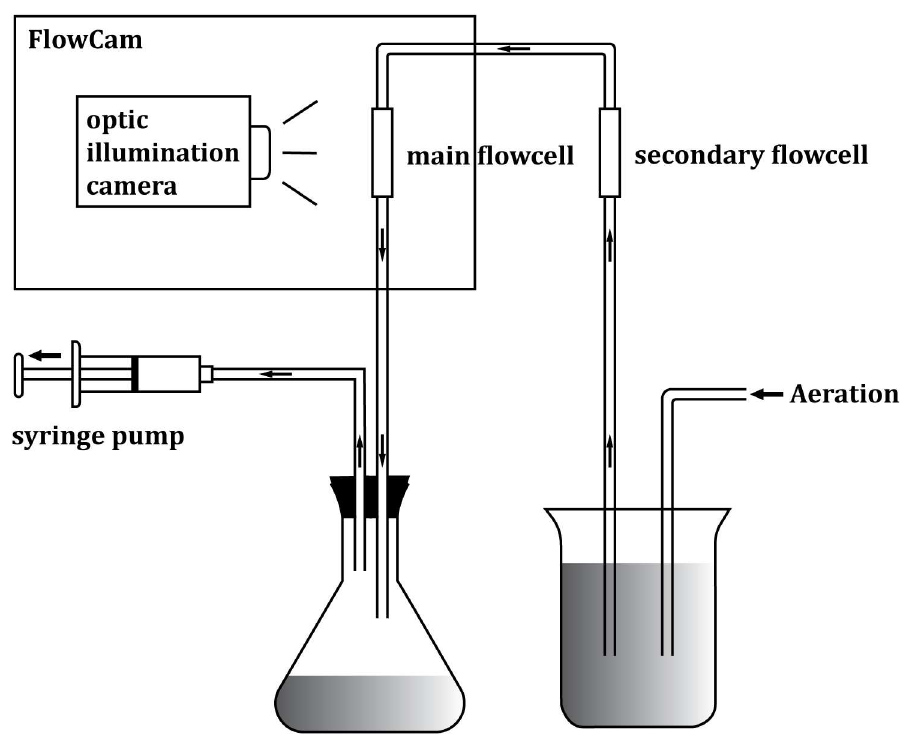
Fig 1. Schematic illustration of the modified FlowCAM procedure for optimizing FlowCAM capacity for zooplankton analysis. Modifications were made upon the standardFlowCAM setup: constant air bubbling(to prevent particles from settling and aggregating), a secondary flowcell(to force particles to align and to providea windowto monitor the occurrence of clogging),an externalsyringe pump, and a receiving conicalflask (to archive sample